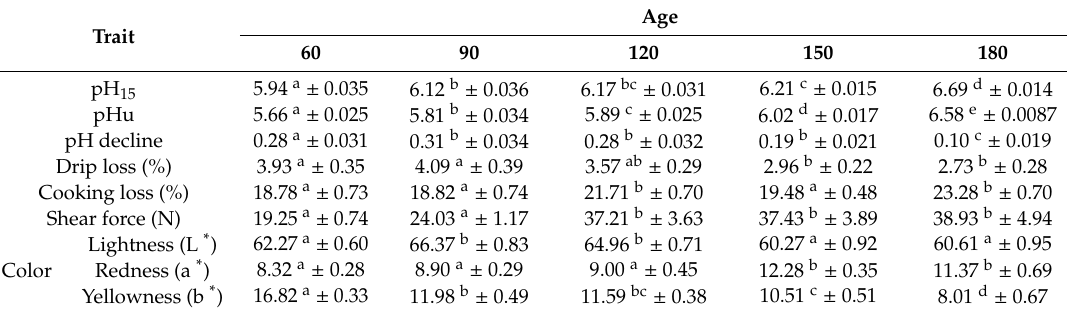
Table 5. E ff ect of age on meat quality traits of Da-Heng meat type birds.